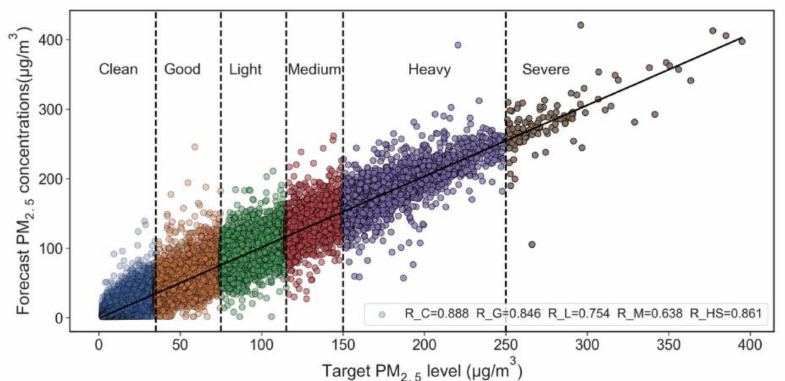
Figure 5. Comparison of forecast results and targets in different pollution levels.